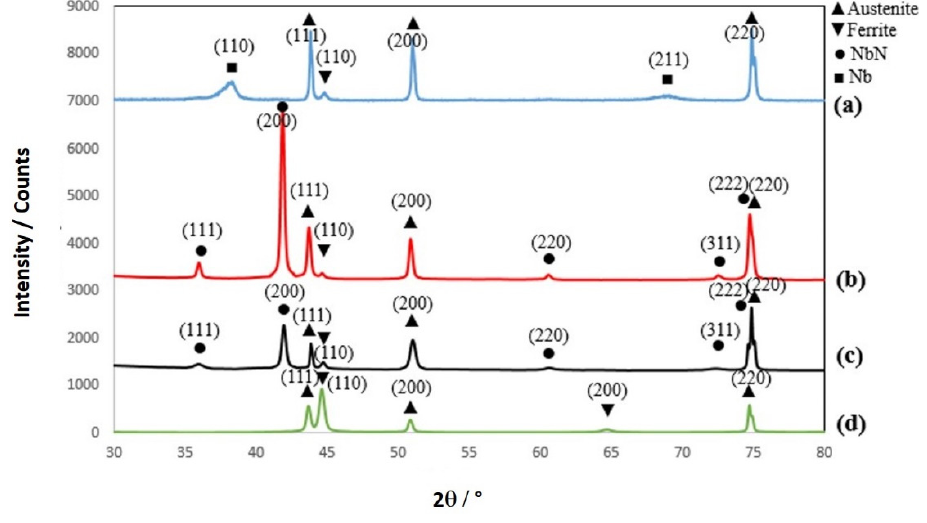
Figure 3. XRD patterns of ( a ) Nb-HT, ( b ) NbN-HT, ( c ) NbN-RT, and ( d ) 304 SS substrate.